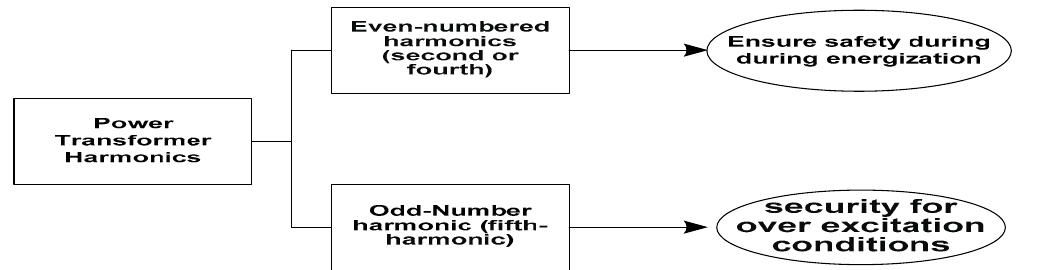
Figure 2. Types of harmonics and their effect on power transformer.